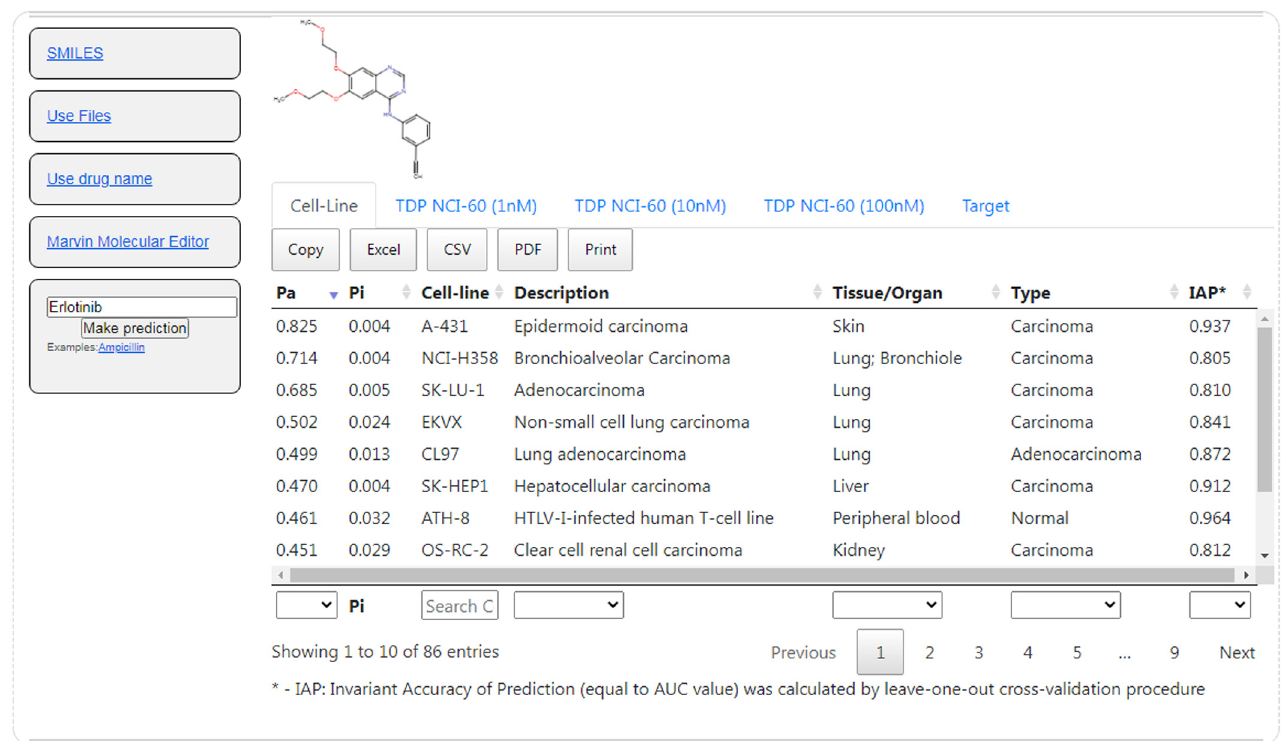
Figure 4. Interface of CLC-Pred 2.0 and prediction results of general cell-line cytotoxicity for erlotinib.